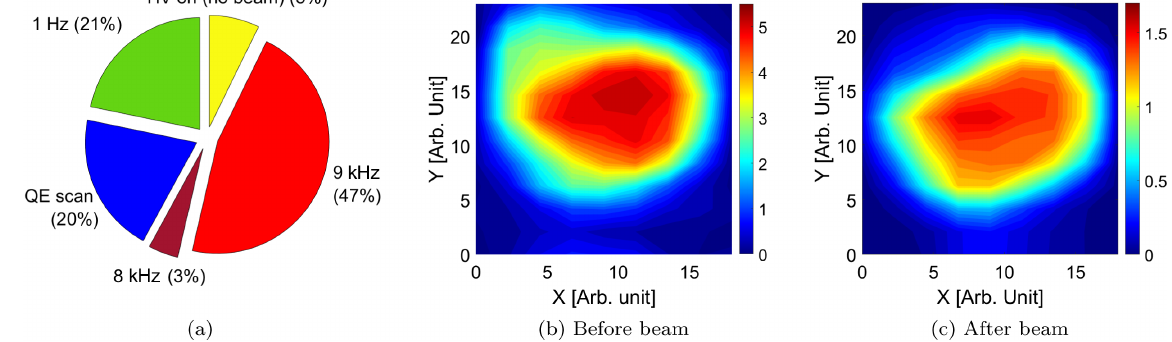
11. Left: fractional amount of time spent on a sample cathode for different operation modes. The percents in the bracket indicate the percentage of overall operation time from this cathode. Middle: QE scan of the cathode before any beam was extracted. Right: QE scan after the cathode was used as per the left pie chart. The colorbar represents QE in percent (%). Note the scale change on the colorbar for “ After beam ” scan compared to “ Before beam ”